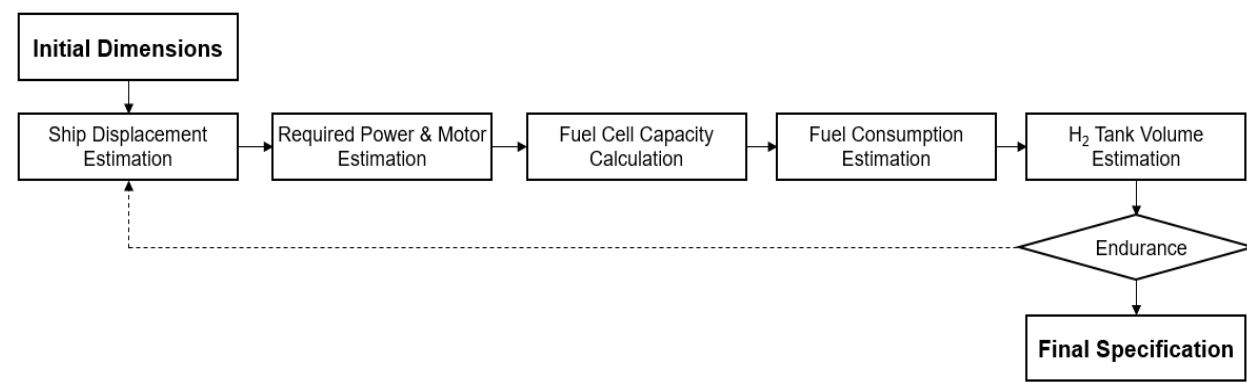
Figure 9. Concept design procedure of nearshore ferry with hydrogen fuel cell